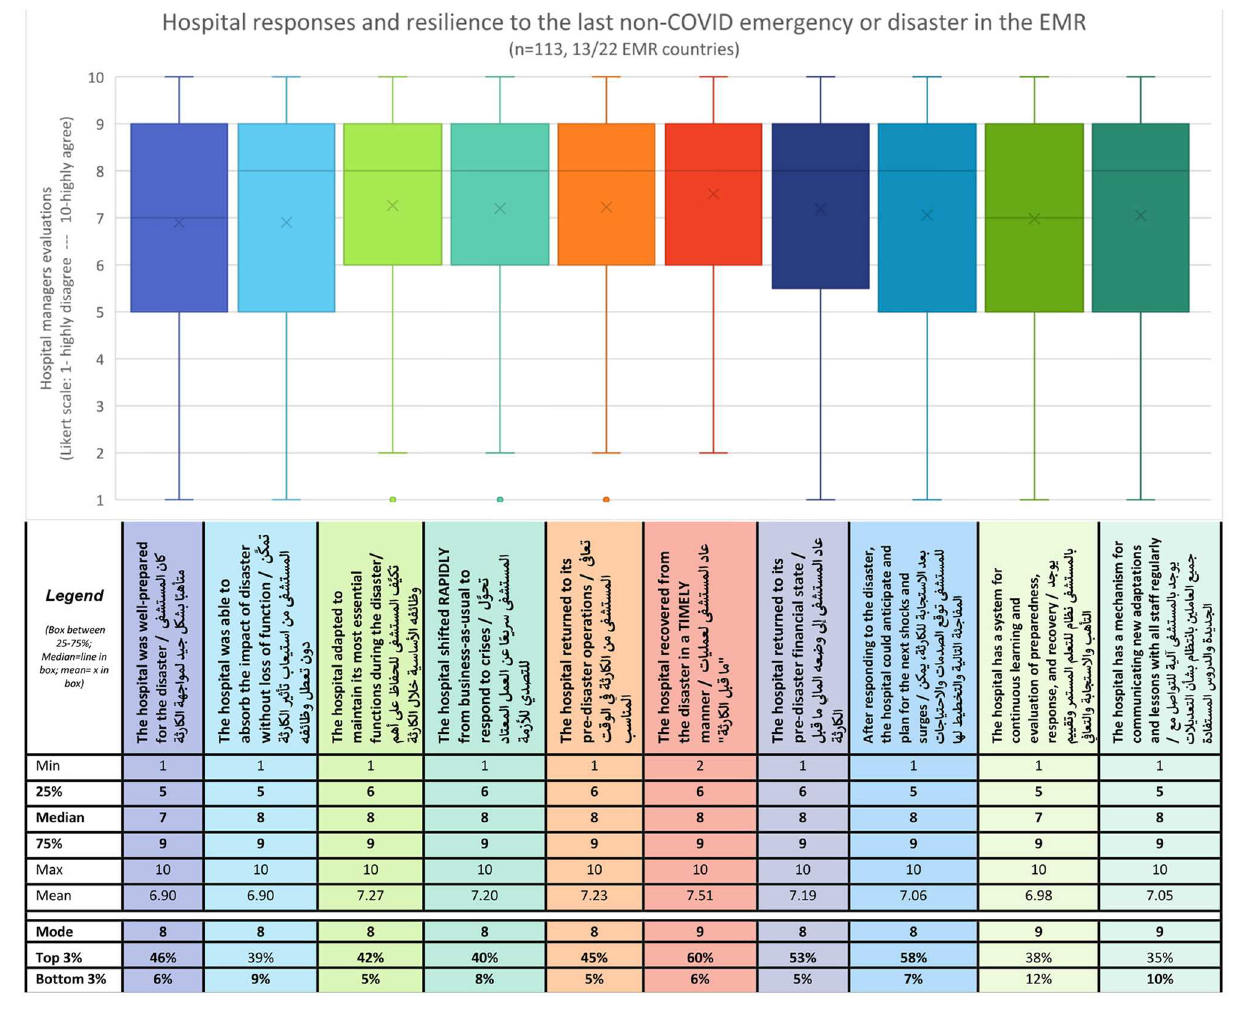
FIGURE7 Ten-point Likert-scale evaluation of hospital resilience to the last non-COVID disaster or emergency.